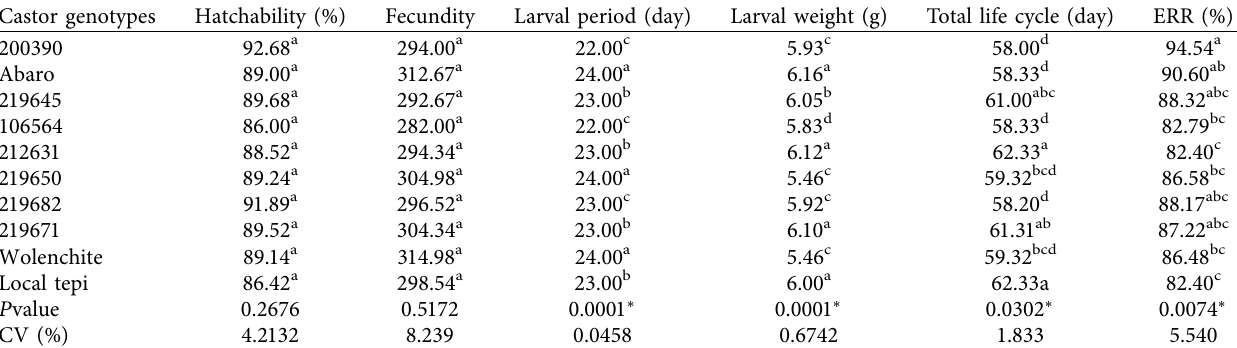
Table 3: Effect of different castor genotypes on hatchability, fecundity, larval period, matured larval weight, life cycle, and effective rate of rearing